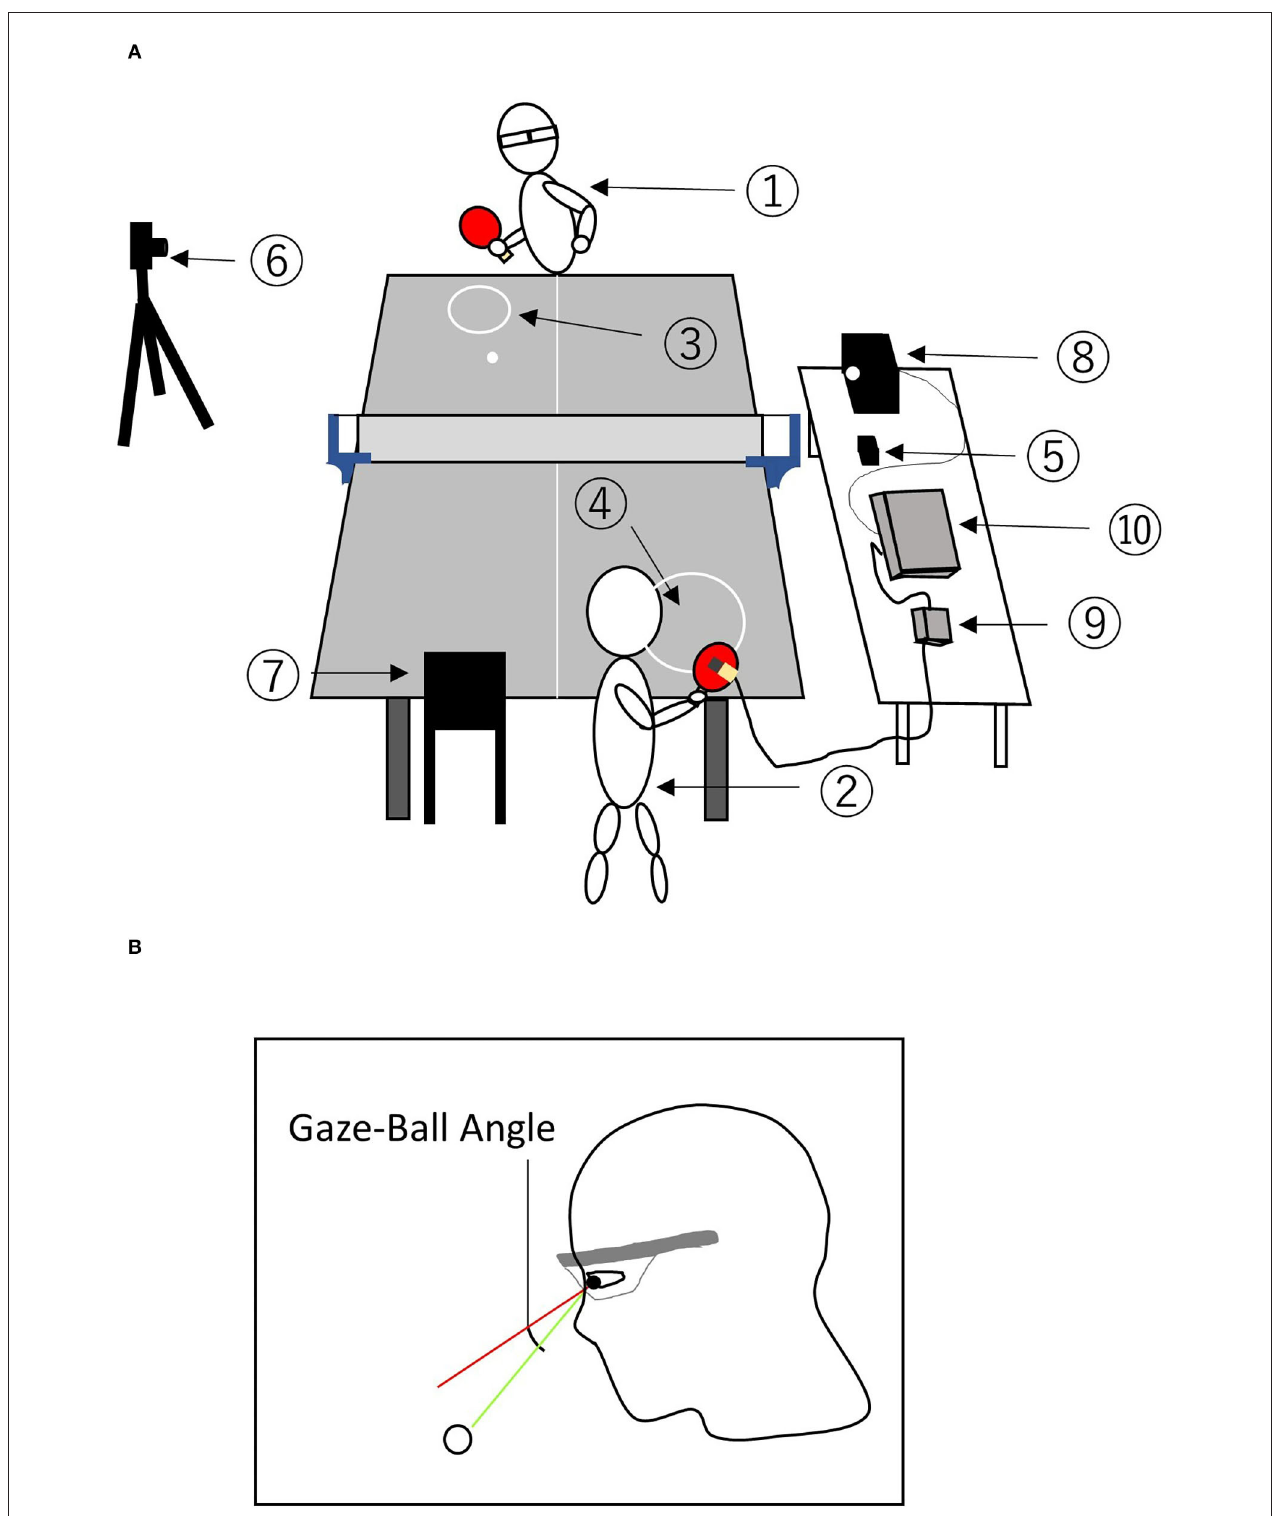
FIGURE 1 | Overview of experimental task (A) and measurement of the gaze-ball angle (B) . (A) ‹ participant, › skilled experimenter, fi participant-side circle targets, fl experimenter-side circle target, (cid:176) speaker, – high speed camera, †‡ LED light, · control box for gyro sensor, (cid:181) waveform generator. (B) The gaze position coordinates were subtracted from the ball position coordinates to estimate the gaze-ball angle.